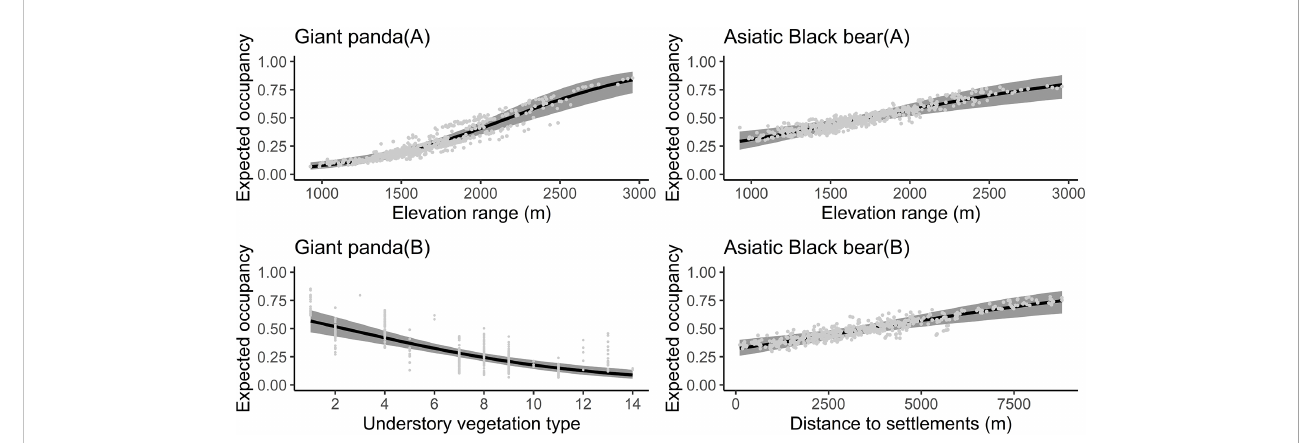
FIGURE 3 The effect of covariates on giant panda (elevation range and understory vegetation type) and Asiatic black bear (elevation range and distance to nearest settlement) occupancy probability predicted by the optimal models ( D AIC ≤ 2) in the Changqing National Nature Reserve. The black curve was fi tted with polynomial regression; gray area indicated 95% con fi dence